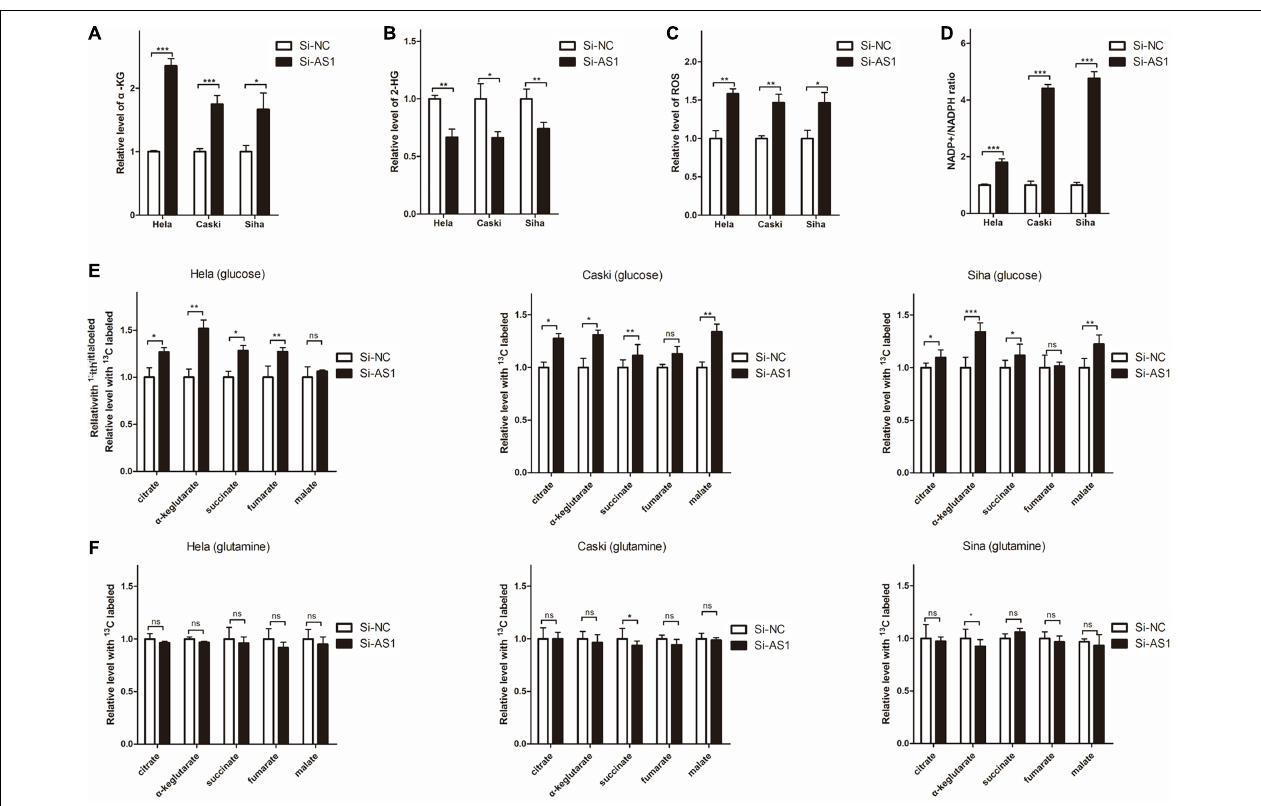
FIGURE 4 | OIP5-AS1 regulates intracellular concentrations of α -KG, 2-HG and redox status in cervical cancer cell. (A–D) Levels of intracellular α -KG (A) , 2-HG (B) , ROS (C) , and NADP+/NADPH (D) in Hela, Caski, and Siha cells knocking down OIP5-AS1 and its control. Data were shown as mean ± SD of three individual experiments. * was P < 0.05, ** was P < 0.01, and *** was P < 0.001, and P value was calculated by Student’s t test. (E,F) Levels of tricarboxylic acid cycle metabolites were determined in Hela, Caski, and Siha cells knocking down OIP5-AS1 and its control using C13 marked glucose (E) or glutamine (F) . Data were shown as mean ± SD of three individual experiments. ns was P > 0.05, * was P < 0.05 and ** was P < 0.01, and P value was calculated by Student’s t